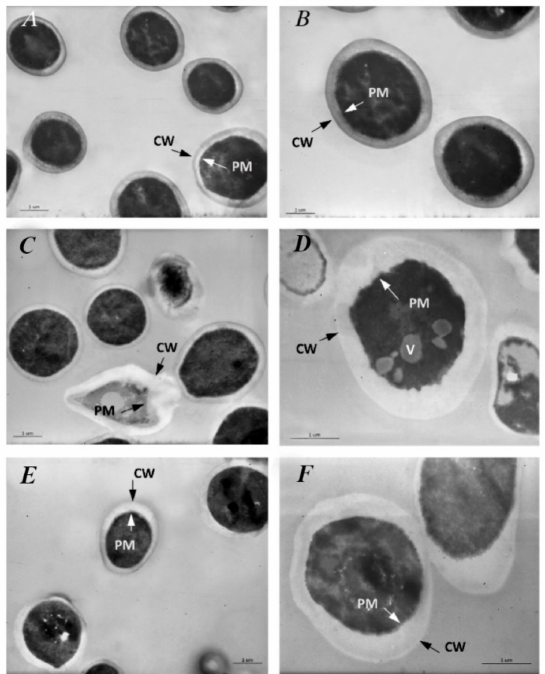
Figure 5. ( A ) Untreated C. albicans shows a prominent and amorphous CW surrounding the PM and the dark intracytoplasmatic space. ( B ) Characteristic microfibrils of β glucans can be observed in the outer layer of the membrane. Microfibrils are intermeshed into thicker bundles, forming a wide-meshed network of fibrils extending into the cell wall. ( C ) After 24 h of contact with TC essential oil, the yeast show features compatible with a fungicidal activity. The photograph shows alteration in the shape and wideness of the CW with rupture of the PM and cytoplasm fragmentation of the yeast. ( D ) In other cells, the PM appears ru ffl ed and vacuoles of medium density and shape could be detected within the cytoplasm. ( E ) Protoplasms treated with CLP extract show an enlargement of the wideness between the CW and PM. ( F ) No morphological alterations could be observed neither in the PM nor in the cytoplasm, suggesting a fungistatic rather than a fungicidal e ff ect of CPL